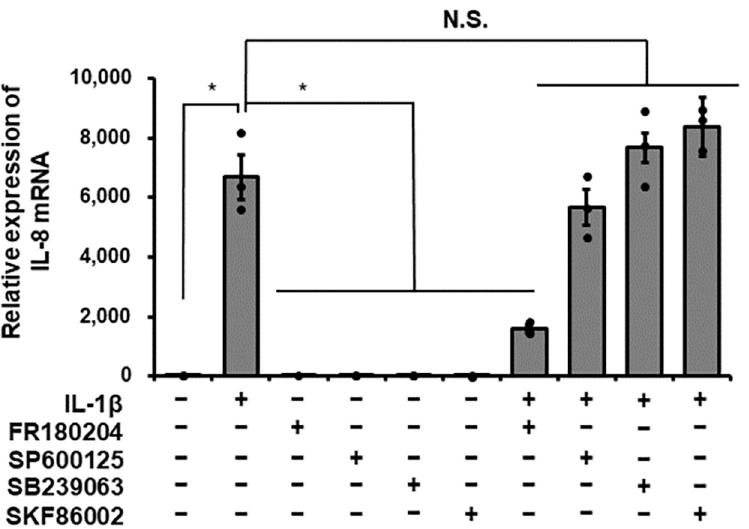
Fig 2. Effect of MAPK inhibitors on IL-1 β -induced IL-8 mRNA expression. Canine dermal fibroblasts were pretreated with or without the ERK1/2 inhibitor FR180204 (50 μ M), JNK inhibitor SP600125 (10 μ M), and p38 inhibitors SB239063 (10 μ M) and SKF86002 (10 μ M) for 1 h and subsequently stimulated with or without IL-1 β (100 pM) for 6 h. After stimulation, IL-8 mRNA expression levels were determined. TBP was used as an internal standard and the expression levels of IL-8 mRNA in IL-1 β -stimulated cells were compared with the expression at 0 h. Results have been represented as mean ± SE from biological triplicates. � P < 0.05.